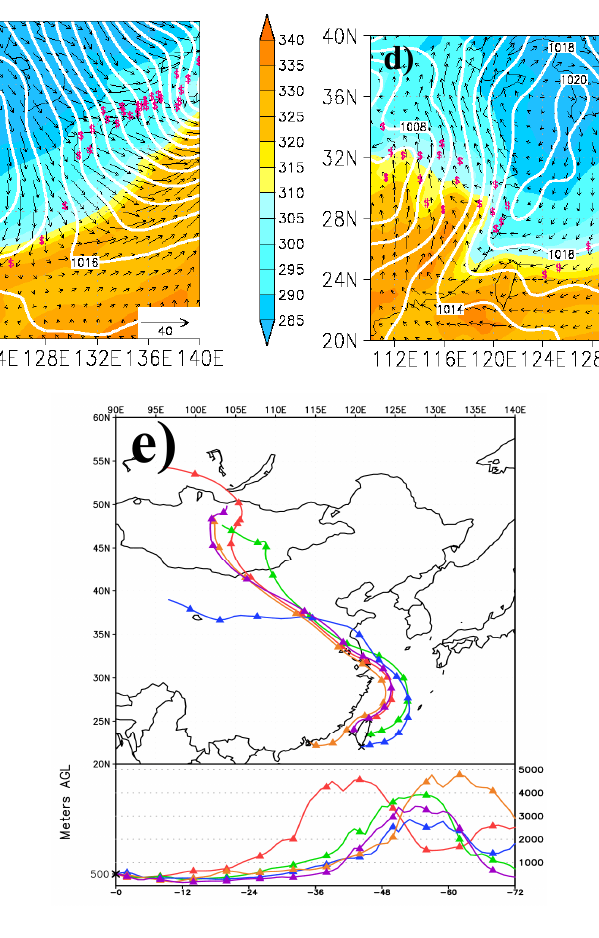
Fig. 4. (a) The ground dust reports (denoted by dollar signs) are from Global Telecommunication System (GTS) data. Wind field and theta-e (colored) are deduced from NCEP GFS data at 925hPa level and contour lines are represented for sea-surface pressure at 18:00UTC 20 March 2010. (b) Same as (a) but for 00:00UTC, 21 March 2010. (c) Same as (a) but for 06:00UTC, 21 March 2010. (d) Same as (a) but for 12:00UTC, 21 March 2010. (e) Result of the HYSPLIT model 3-day backward trajectory analysis at altitude of 500m starting from the time of peak value for stations at Taiwan (WL, HL, HC, MG) and TM at Hong